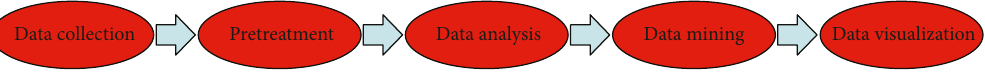
Figure 1: Team selection mode in the context of big data.